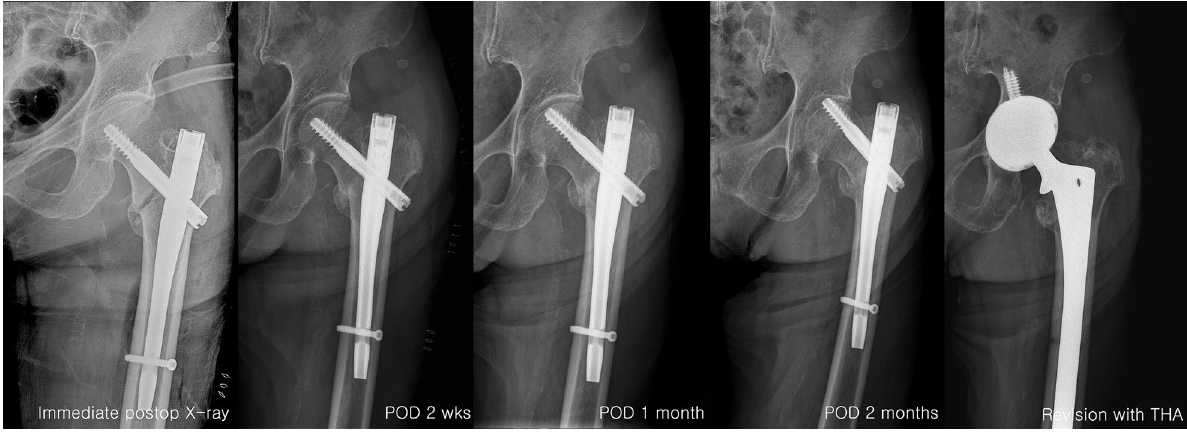
Figure 7. Cut-out example (Patient 2).